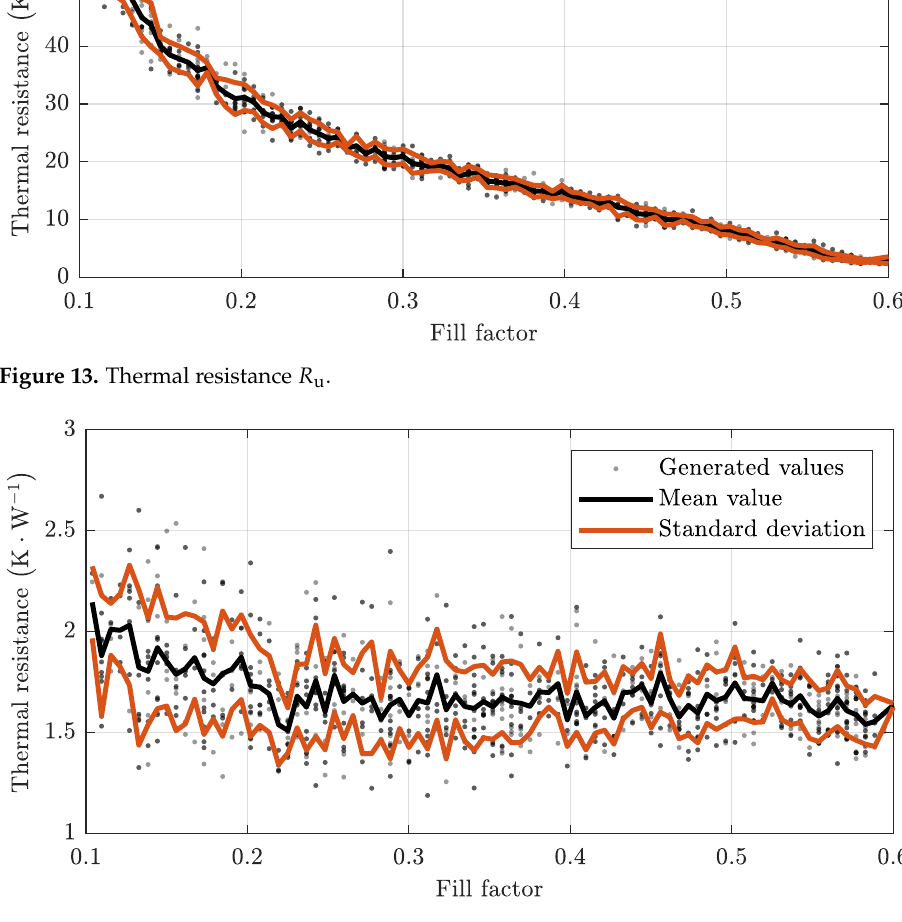
Figure 14. Thermal resistance R d